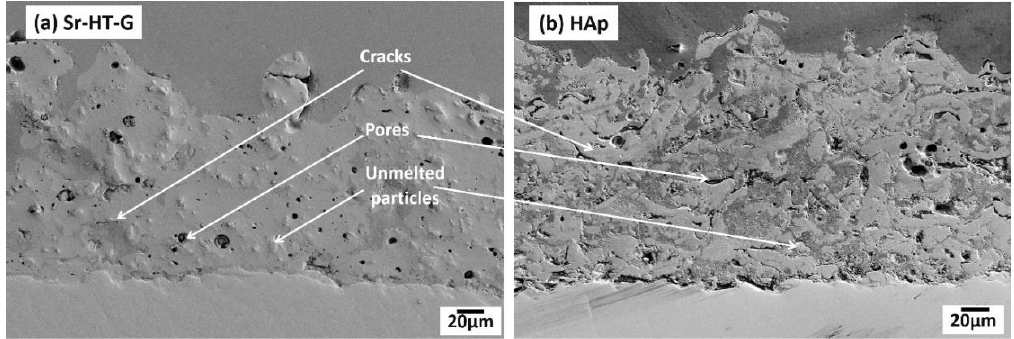
Figure 5. Microstructure of Sr-HT-G ( a ) and HAp ( b ) on coating cross section.